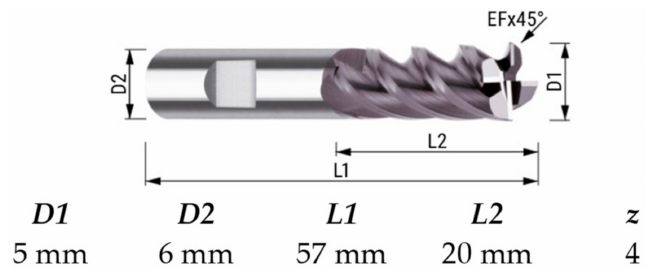
Figure 1. The geometry of the milling